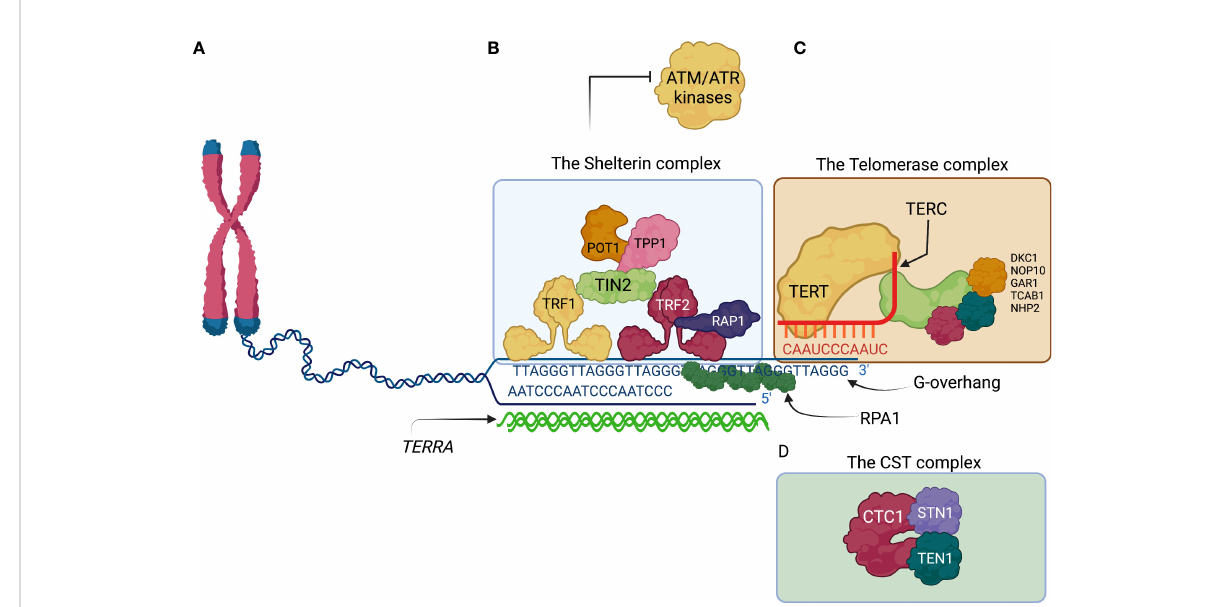
FIGURE 2 The ends of the human lineal chromosomes are protected by telomere associated proteins. (A) The lineal nature of the human chromosomes possesses a challenge for integrity maintenance of the human genome. The telomeres at the end of the chromosomes consist of repetitive sequences TTAGGG and their complementary sequence AATCCC. A G-overhang composed by the TTAGGG sequence is the result of incomplete DNA fi ll-in activity by DNA polymerases at every round of DNA duplication. The G-overhang is bound by RPA1 subunits conferring protection from nucleolytic degradation. (B) Shelterin is telomere protecting complex that is composed by six proteins. TRF1 and TRF2 directly bind the telomeric DNA sequences and recruit other members of the Shelterin complex. Shelterin promotes the t-loop lariat conformation of the G-overhang and inhibits activation of the checkpoint kinases, ATM by TRF2, and ATR by POT1. (C) The telomerase complex is a ribonucleoprotein whose main components are TERT and TERC proteins. TERT synthetizes telomeric DNA using TERT as a template and extends the TTAGGG overhang. (D) The CST complex is composed by the CTC1, STN1, and TEN1. CST complex recruits Pol-a-primase to help fi ll in the recently extended TTAGGG with the complementary AATCCC. CST complex also inhibits telomerase activity, preventing excessive telomere extension. ATM, ataxia telangiectasia mutated; ATR, ATM and Rad3 related; CTC1, conserved telomere protection component 1; POT1, protection of telomeres 1; RPA1, Replication Protein A1; STN1, suppressor of cdc thirteen 1; TEN1, telomeric pathway with STN1;